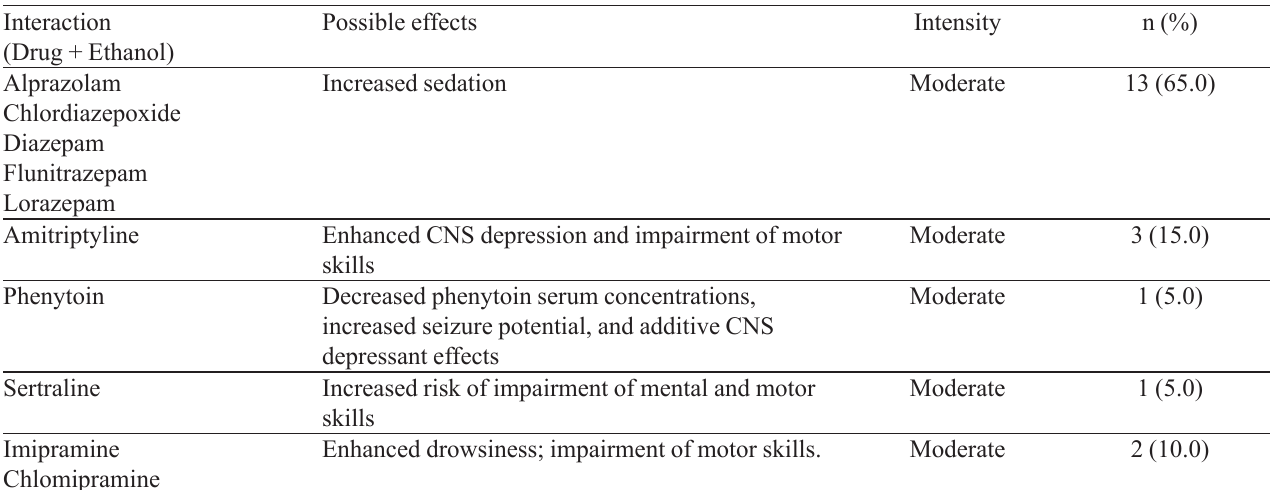
TABLE III - Potential ethanol-drug interactions, based on reported prescribed medications and regular alcohol use in the elderly sample population